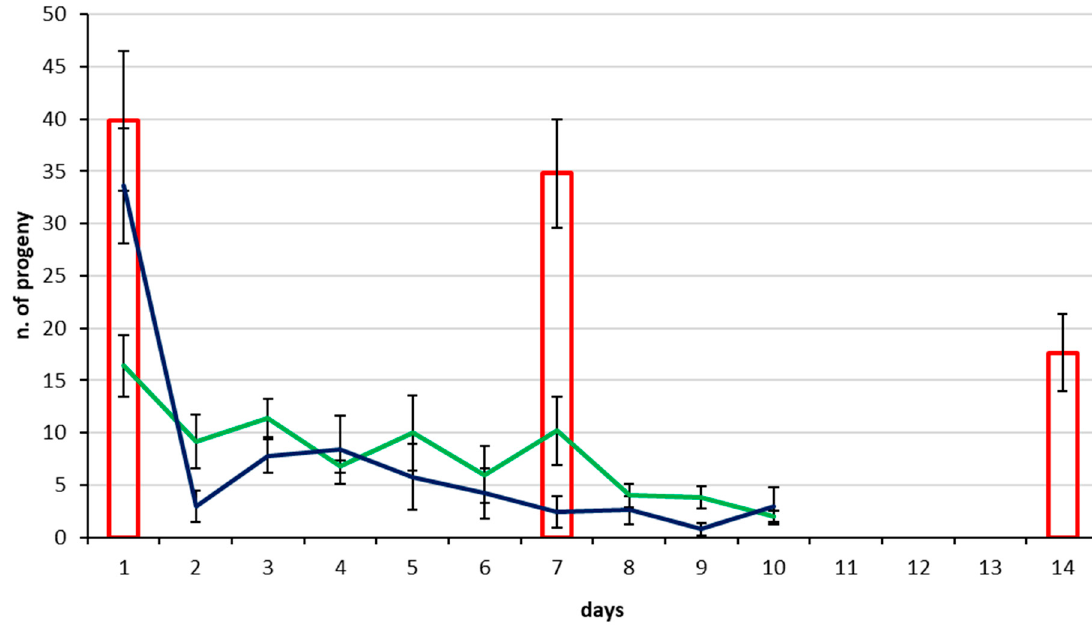
Figure 2. Mean number (±Standard Error S.E.) of progeny produced by Trissolcus japonicus Council for Agricultural Research and Economics (CREA) colony under different supply regimes of Halyomorpha halys host egg masses. Green line = 1-day-old females with host egg masses offered daily for 10 consecutive days (1 d × 10 d); blue line = 7-day-old females (host deprived until day 7) with host egg masses offered daily for 10 consecutive days (7 d × 10 d); histograms = 7-day-old females (host deprived until day 7) with host egg masses offered once a week for three consecutive weeks (7 d × 3 w); see text for more details.